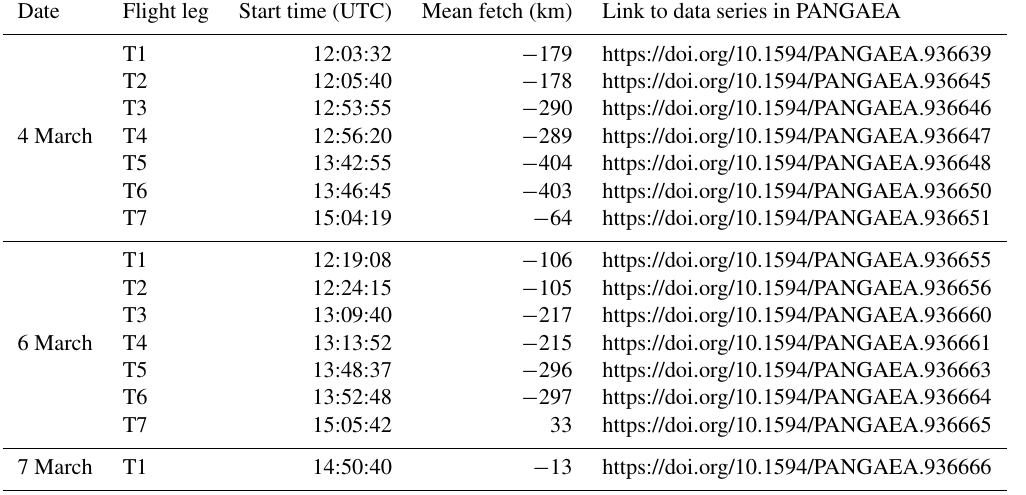
Table 1. Overview of all aircraft ascents and descents performed mostly upwind of the sea ice margin on 4, 6, and 7 March 2013. ∗